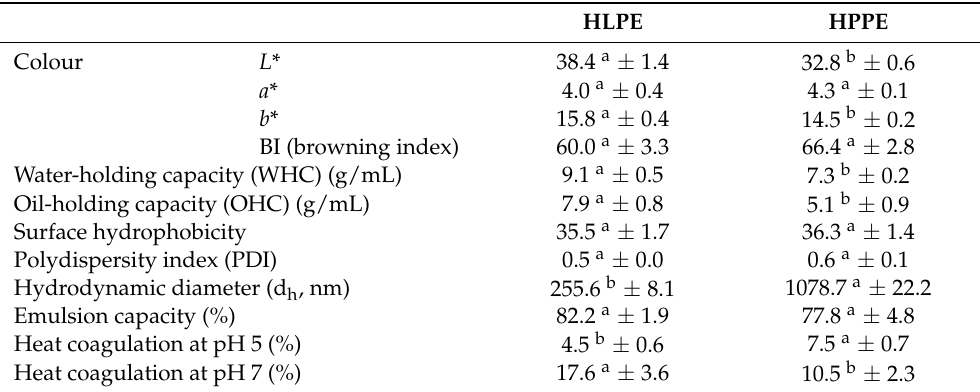
Table 3. Techno-functionality and physiochemical characteristics of the Huhu larvae and pupae protein extract powder